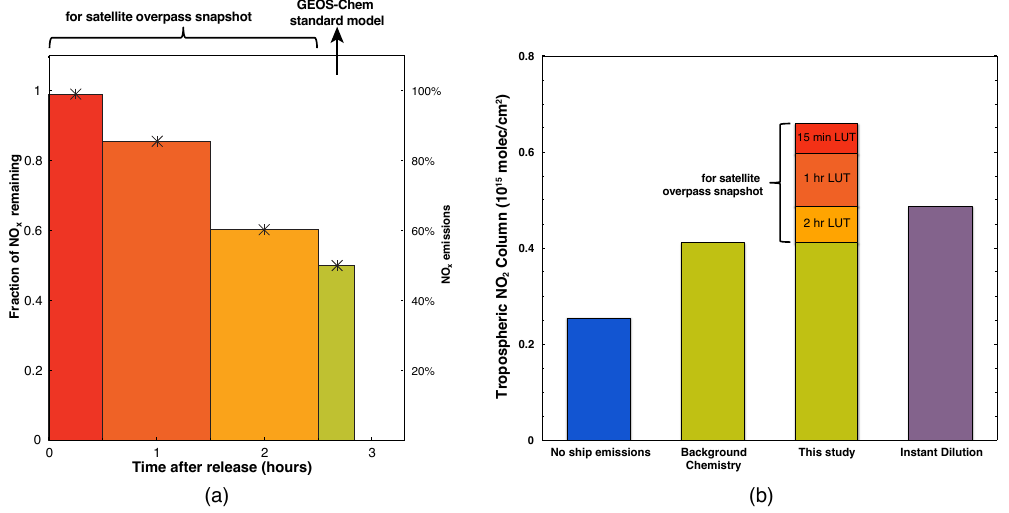
Fig. 1. (a) Fraction of NO x remaining as a function of time passed since emission. Fractions have been calculated by the PARANOX Gaussian plume model for a grid cell in the Bay of Biscay (averaged between 13:00 and 15:00LT) and include the effects of plume expansion and chemistry (Vinken et al., 2011). Resulting emissions used for the model snapshot are the fractions of NO x remaining multiplied by the emissions. The green column represents the emissions that are propagated in the regular model chemistry. (b) Simulated tropospheric NO 2 columns for a grid cell with ship emissions in the Bay of Biscay at 1 June 2005. The orange to red colours in the third bar represent the contribution to the column from emissions from the last 2.5h, which are added to the background column to provide model output consistent with a satellite snapshot at 13:30LT. As reference, the tropospheric NO 2 columns for this location without ship emissions (blue) and when using instant dilution (purple) are also